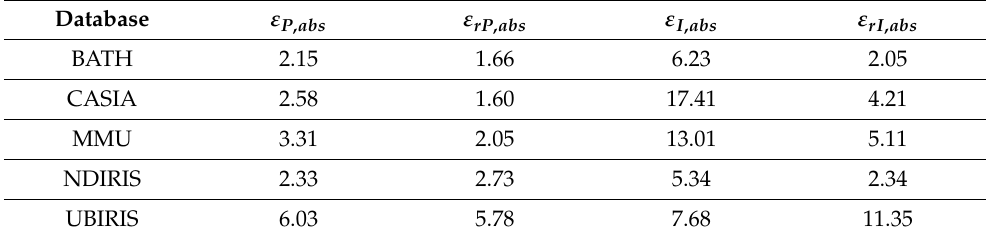
Table 2. Errors of base radii detection, pixels.